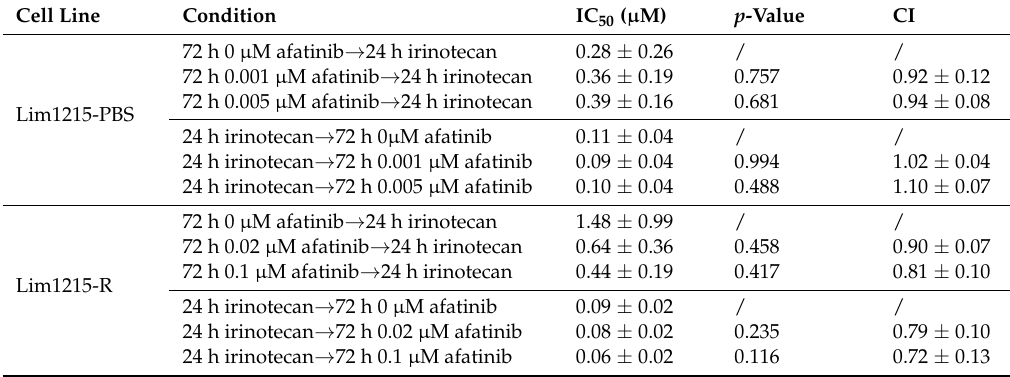
Figure 8. The cytotoxic effect of irinotecan followed by afatinib in CRC cell lines with different sensitivities to cetuximab. Dose–response curves for the cetuximab-sensitive ( a , c ), corresponding isogenic acquired cetuximab-resistant ( b , d ) and intrinsically cetuximab-resistant ( e ) CRC cell lines indicate an additive to subadditive effect. Survival curves are corrected for the cytotoxic effect of 72 h afatinib alone. Cells were treated with fixed concentrations afatinib, which were based on the outcome of the monotherapy experiments. Table 2. IC 50 , combination index (CI), and standard errors for CRC cell lines after sequential treatment with afatinib followed by irinotecan as well as irinotecan followed by afatinib. CI < 0.80, CI = 1.00 ± 0.20 and CI > 1.20 indicated synergism, additivity, or antagonism, respectively.